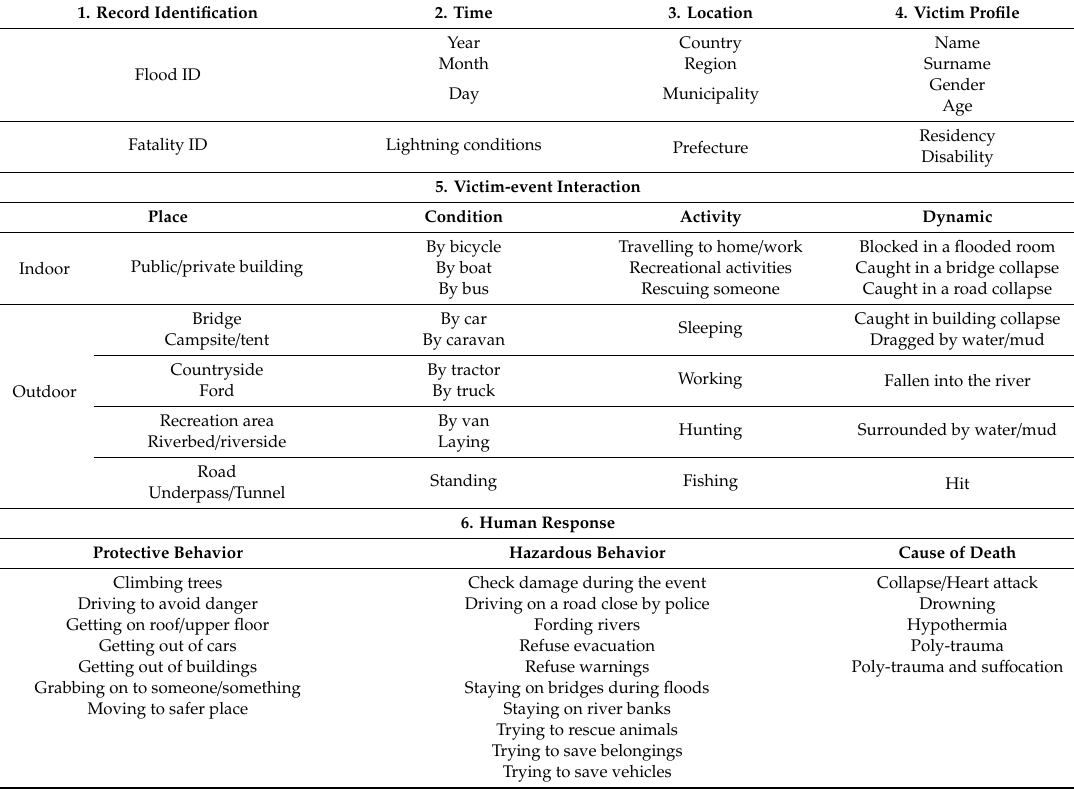
Table 3. Sections and fields of EUFF